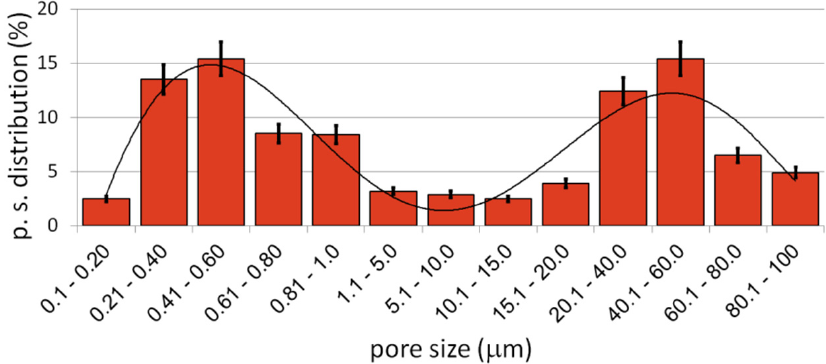
Figure 4. Ti20Nb5Zr foam pore size distribution.